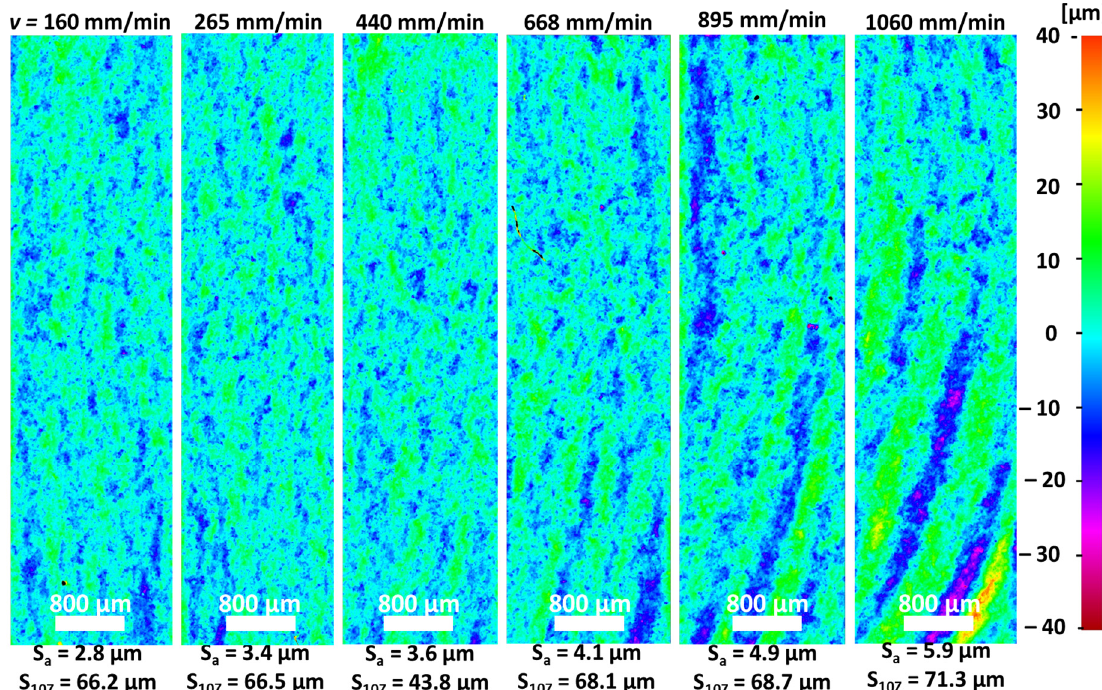
Figure 10. The variation in surface roughness parameters for various feed rates ( v ) in AWJ cutting.